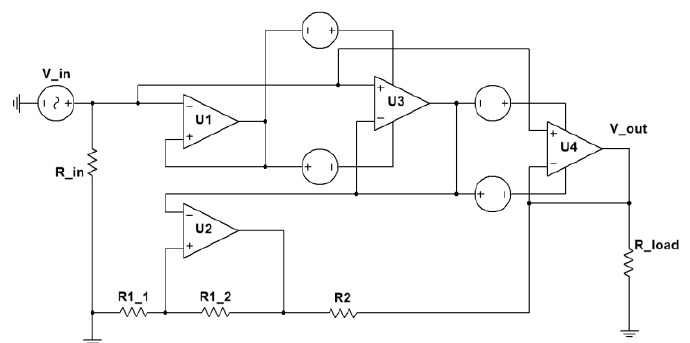
Figure 3. Circuit schematic for the three-level buffer amplifier with output-current amplification. (Operational amplifier: U1, U2, U3, and U4; Resistance: R_in, R1_1, R1_2, R2, R_load).